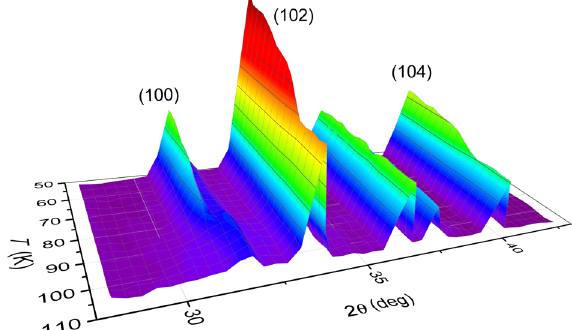
FIG. 7. Contour plot of the evolution of the neutron-powder- diffraction patterns recorded on cooling from 110 to 50 K. The data reveal the appearance of magnetic Bragg reflections of the type (1, 0, L ¼ 2 n ) corresponding to the long-range magnetic ordering of the Mn1 ions occupying the honeycomb layers.